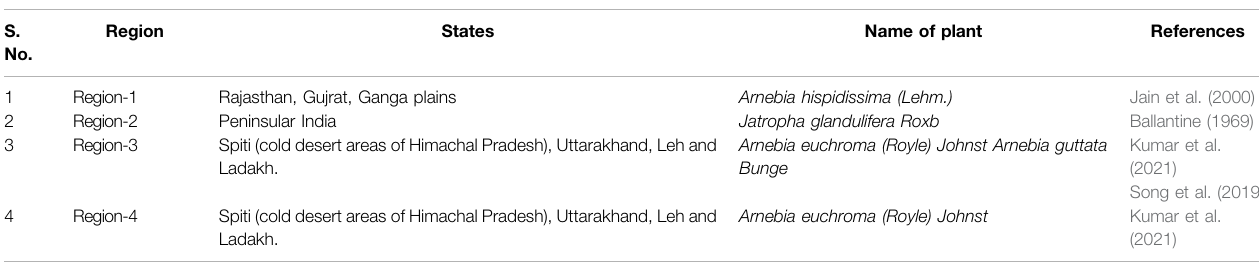
TABLE 3 | Abundance of shikonin in